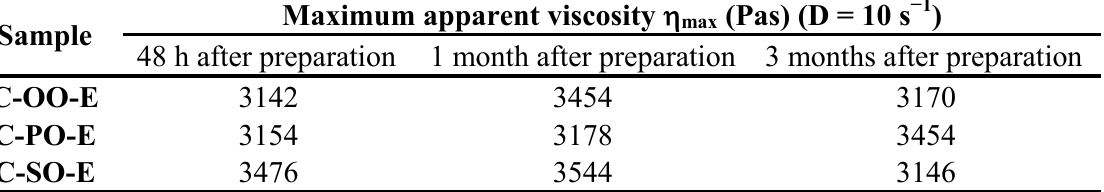
Table 3. Rheological characteristics/ samples stored at 45 ± 2 °C.